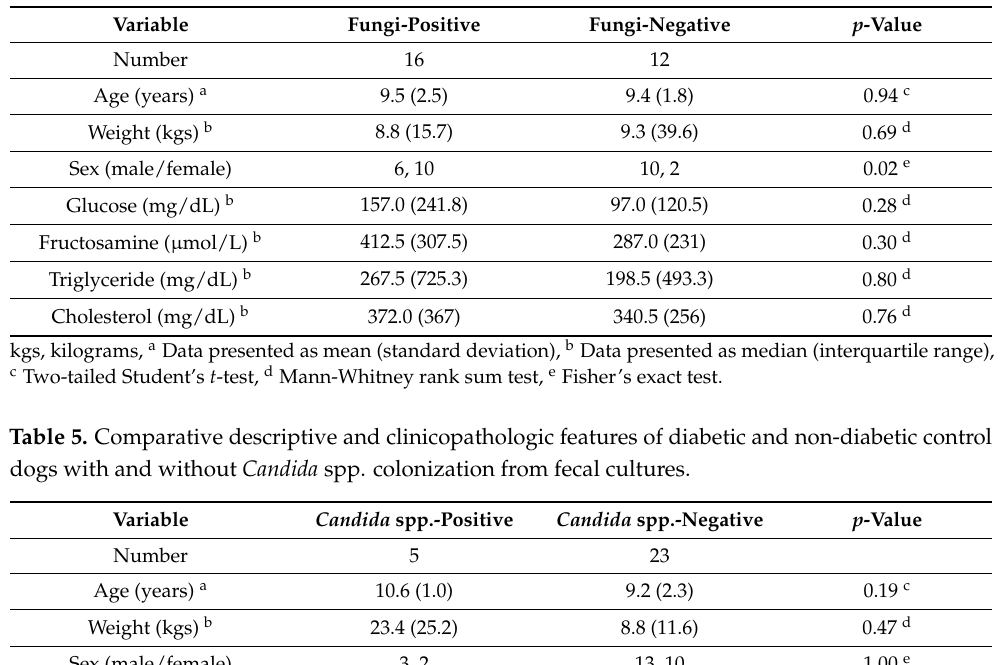
Table 4. Comparative descriptive and clinicopathologic features of dogs with and without fungal colonization from fecal cultures.